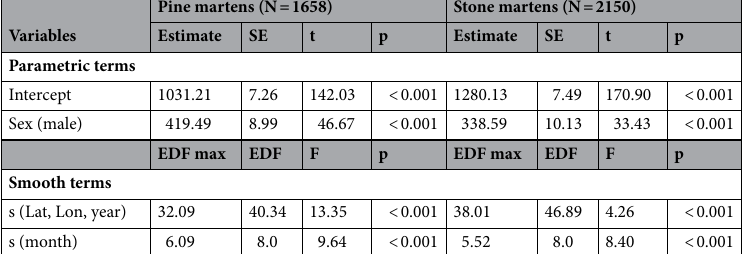
Table 1. Results of GAM analyses of the sex and smoothed effects of month and three-way interaction with latitude (Lat), longitude (Lon) and time (year) testing for the spatial and temporal gradient and related body mass of pine and stone martens in Europe.